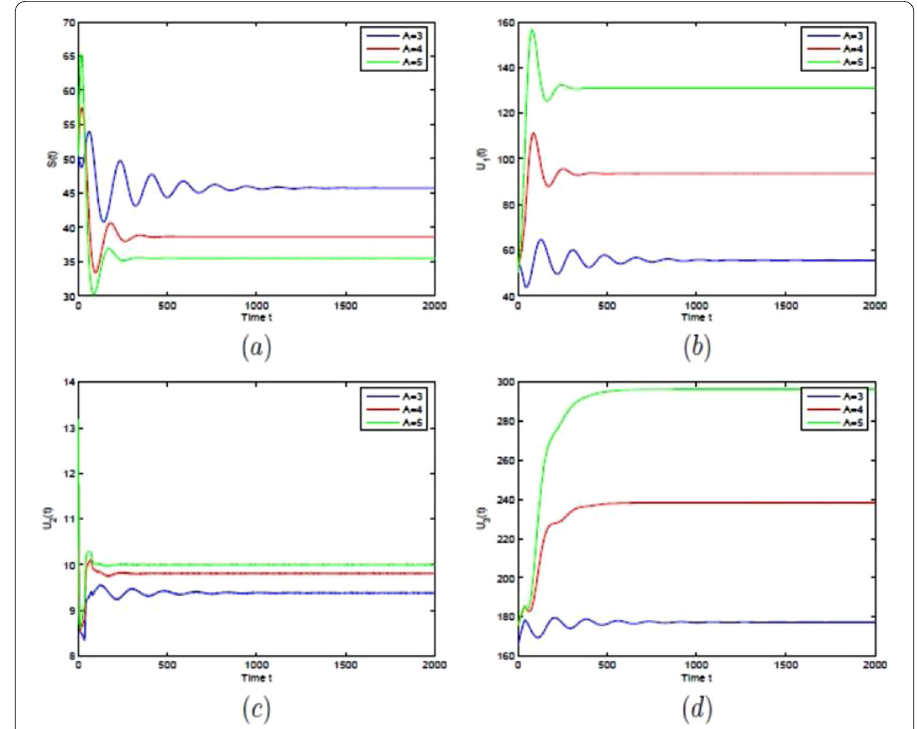
Figure 6 Effect of A on all classes for τ = 35.25: ( a ) S , ( b ) U 1 , ( c ) U 2 , ( d ) U 3